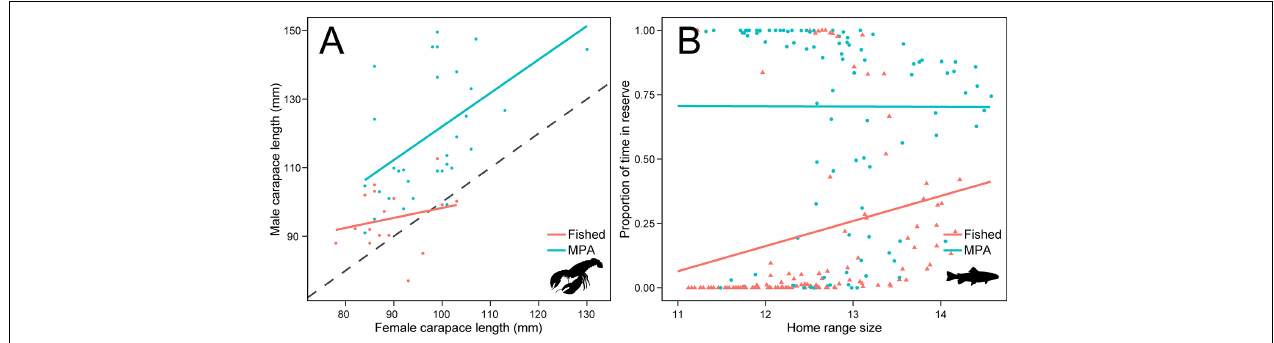
FIGURE 3 | Evidence of altered selection landscapes in MPAs: (A) size-assortative mating in H. gammarus inside and outside a lobster reserve. Data points are mating confirmed by genetic parentage studies on lobster populations in protected (blue) and harvested (orange) states. Stippled line denote isometry (Y = X) where females and males are equal in size (modified from Sørdalen et al., 2018); (B) disparate protection potential (proportion of time spent in a no-take MPA) with increasing home range size in S. trutta tagged inside (blue, circles) and outside (orange, triangles) of the no-take zone in Tvedestrand fjord (modified from Thorbjørnsen et al.,